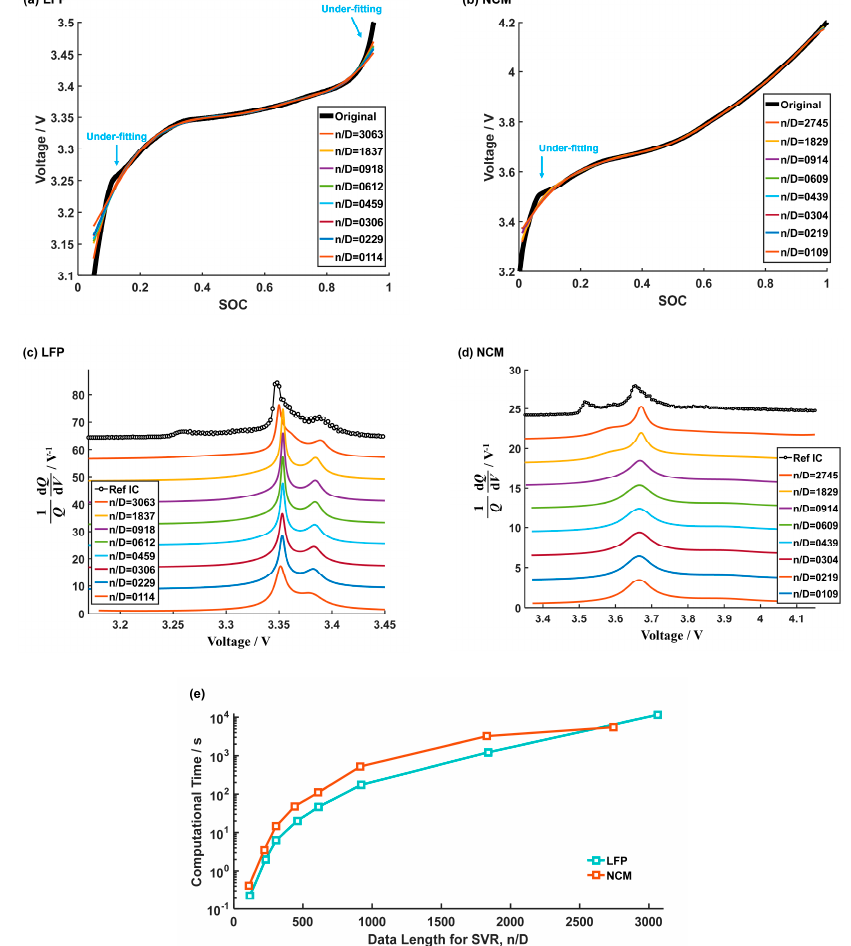
Figure 7. The relationship between the data length and the performances of the SVR algorithm. ( a ) The fitting of the voltage for Cell A with LFP cathode. ( b ) The fitting of the voltage for Cell B with NCM cathode. ( c ) The fitting results of the IC curves for Cell A with LFP cathode. ( d ) The fitting results of the IC curves for Cell B with NCM cathode. ( e ) Computational time versus the data length for the SVR algorithm.